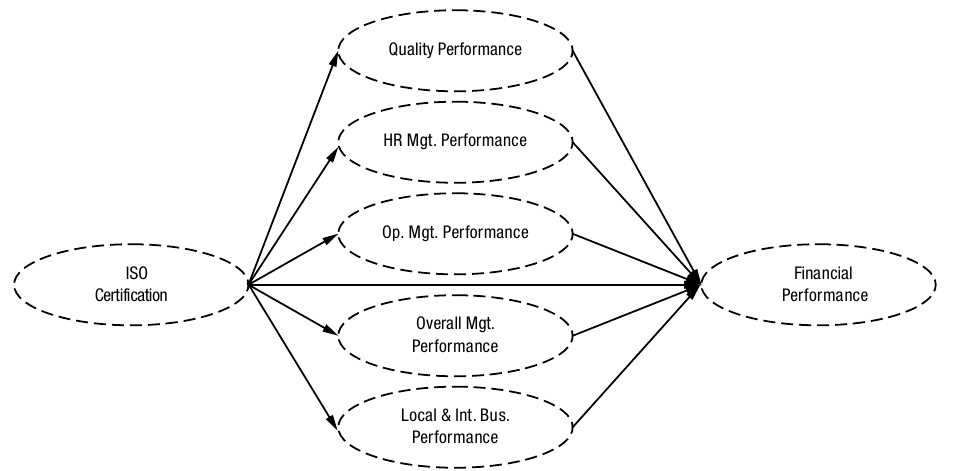
Quality Performance